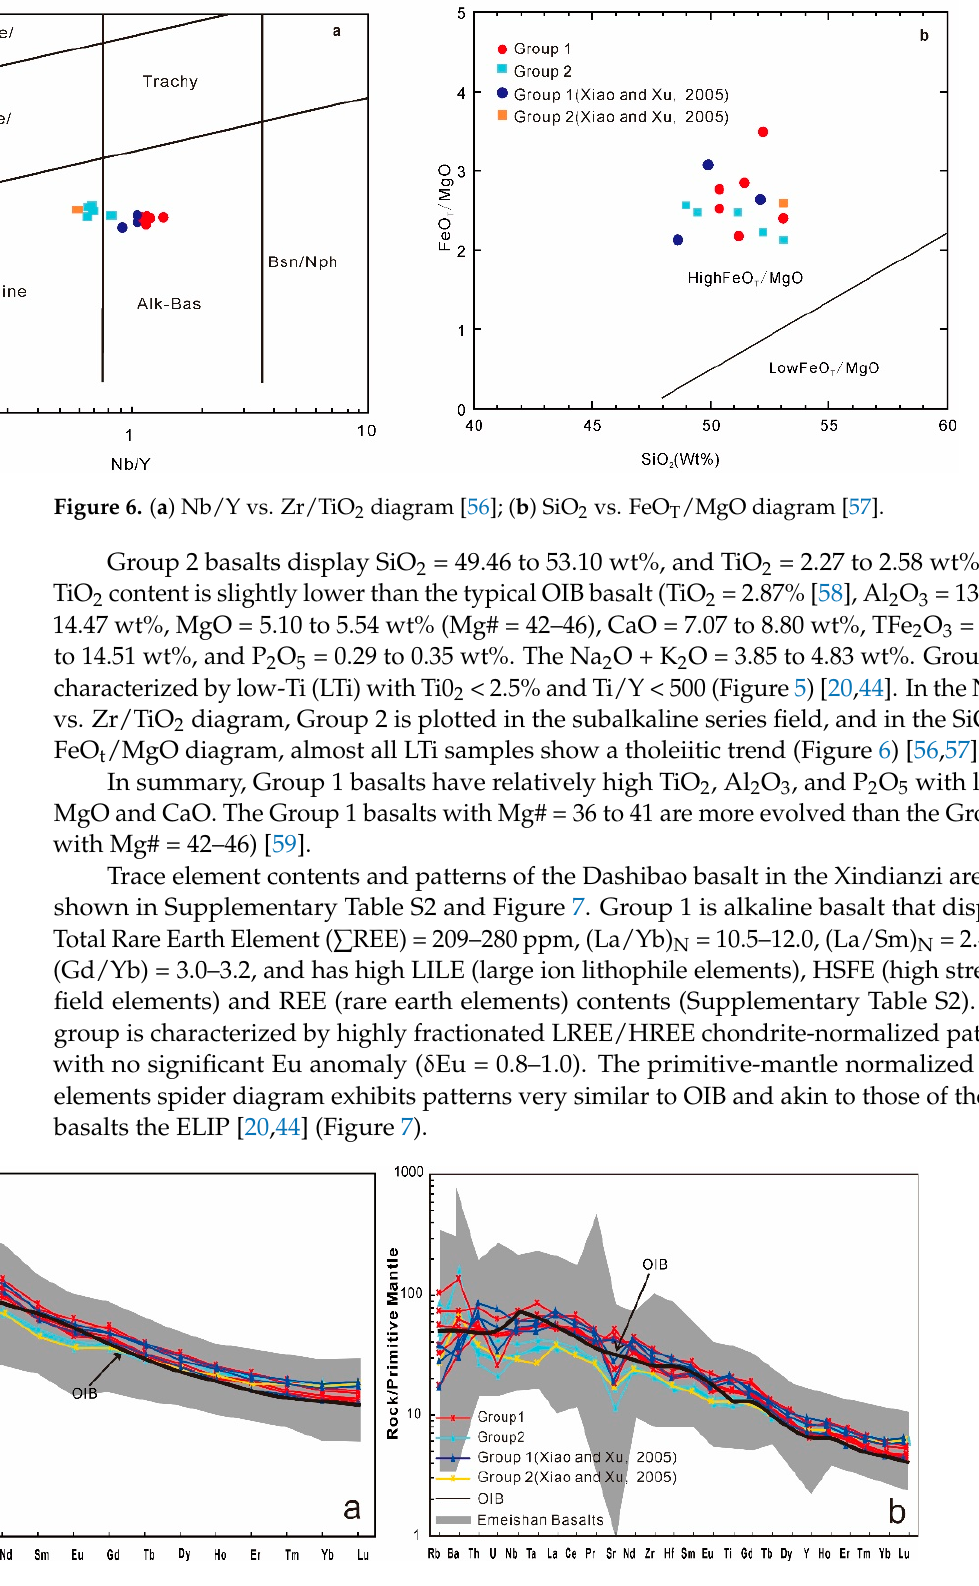
Figure 5. Diagrams showing the variation of Mg# and Th/Nb against Ti/Y for the Emeishan basalts. Shaded areas indicate the domains of the Emeishan basalts from the Binchuan area [20,44].